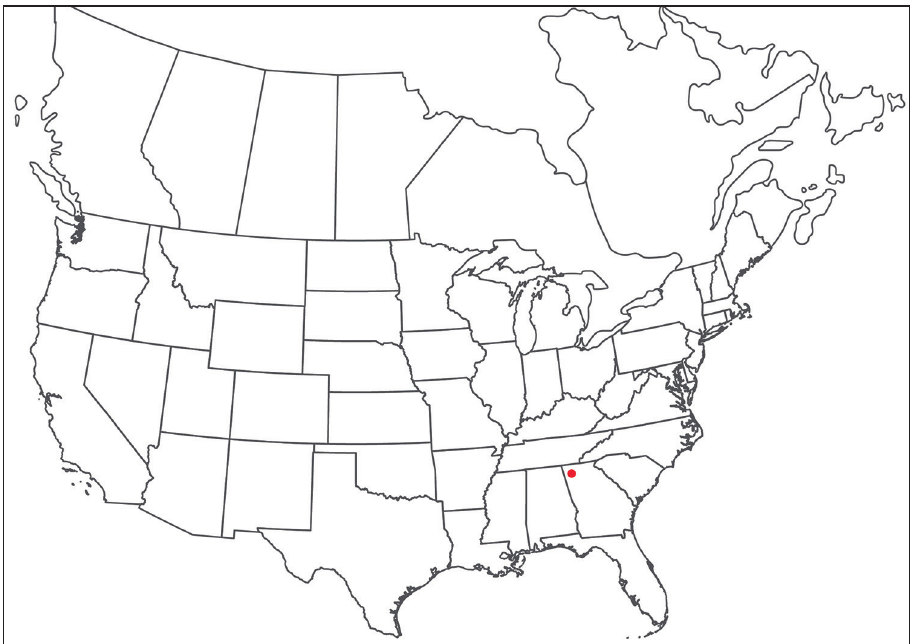
Figure 47. Torrenticola danielleae sp. n.